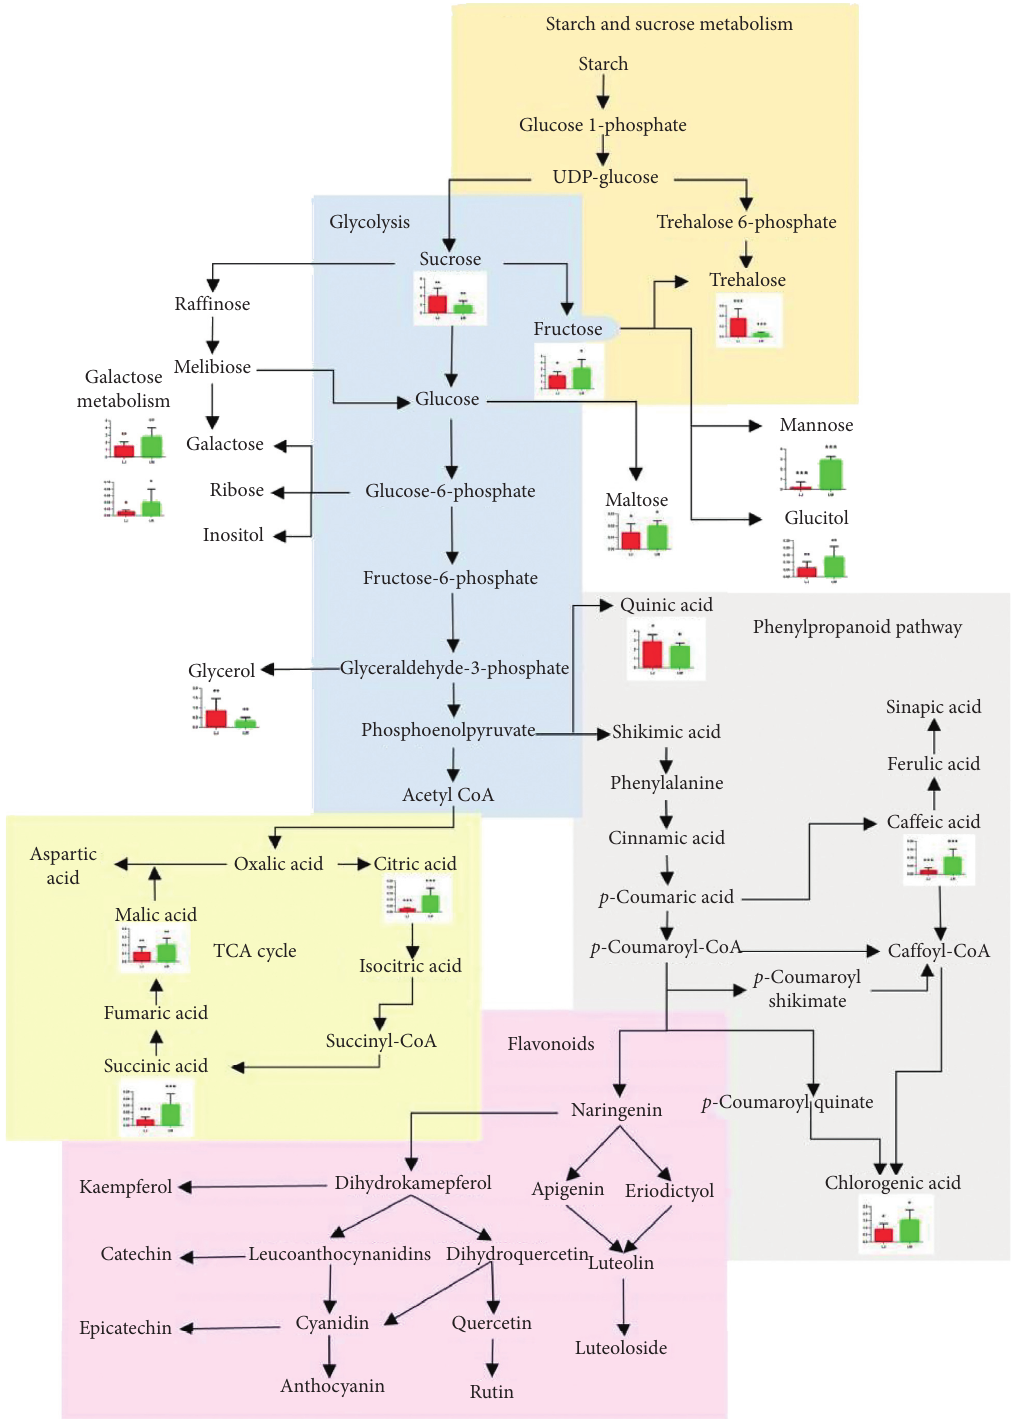
Figure 4: The metabolic pathway map, including the galactose metabolism, the starch and sucrose metabolism, the glycolysis, the phenylpropanoid pathway, the flavonoids metabolism, and the TCA cycle. In the relative peak area figure, red represents LJ and green represents